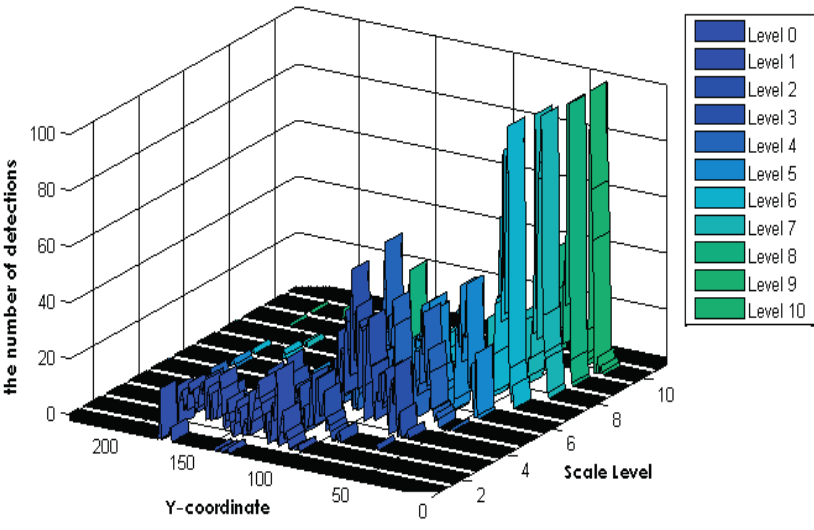
Figure 1. Accumulated Hough windows map information based on voting detection location. Detection locations are detected by applying naïve human detection [7] to eleven densely sampled levels of